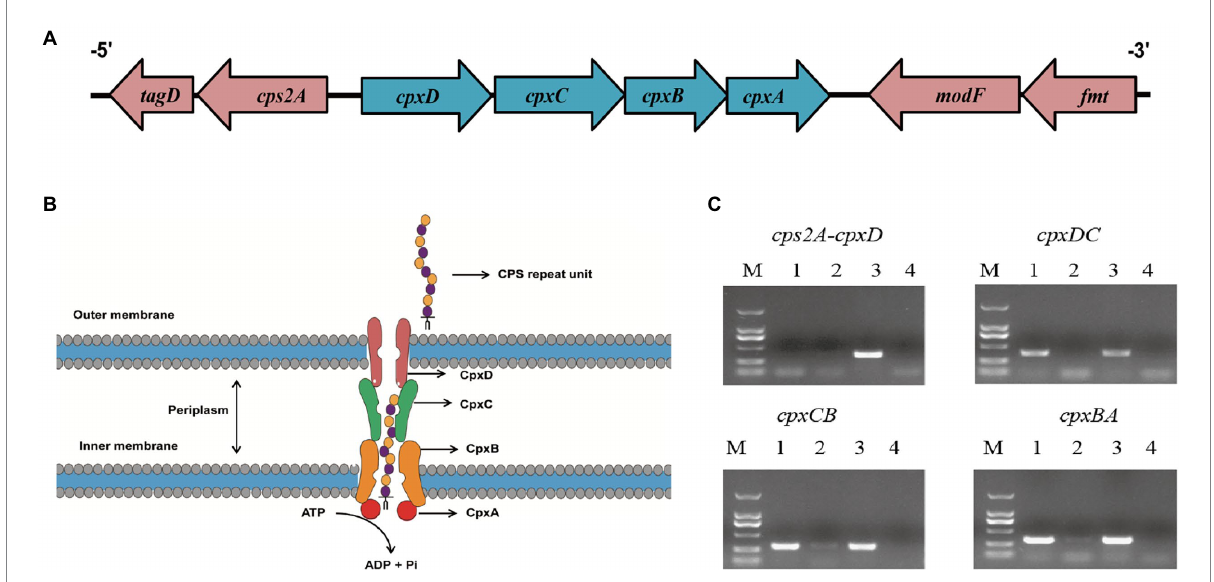
FIGURE 2 The cpxD , cpxC , cpxB, and cpxA genes form a single operon. (A) Schematic presentation of the capsule export locus. (B) Diagram showing the role of CpxD, CpxC, CpxB, and CpxA (capsular polysaccharide export protein) in CPS synthesis. (C) RT-PCR analysis confirmed that the cpxD , cpxC , cpxB, and cpxA (capsular polysaccharide export gene) genes form an operon. The Lane 1–4 were cDNA, total RNA, genomic DNA, and no-template control,